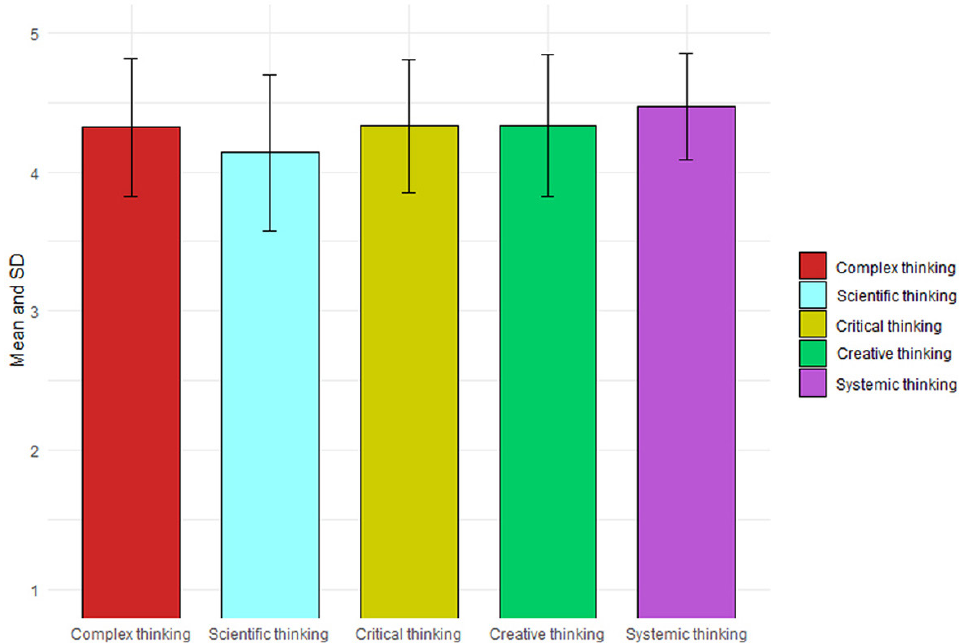
Fig. 2. Competency of complex thinking: means and standard deviations bar chart of competency and